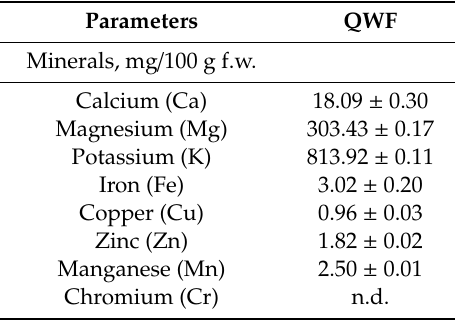
Table 2. Chemical composition and mineral content of quinoa